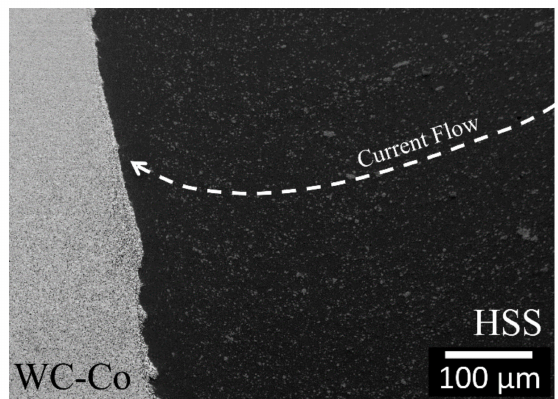
Figure 11. Higher FESEM magnification of the W4 region shown in Figure 2. The white dashed arrow indicates the co-alignment pattern of the dissolved carbides due to the current density flow.